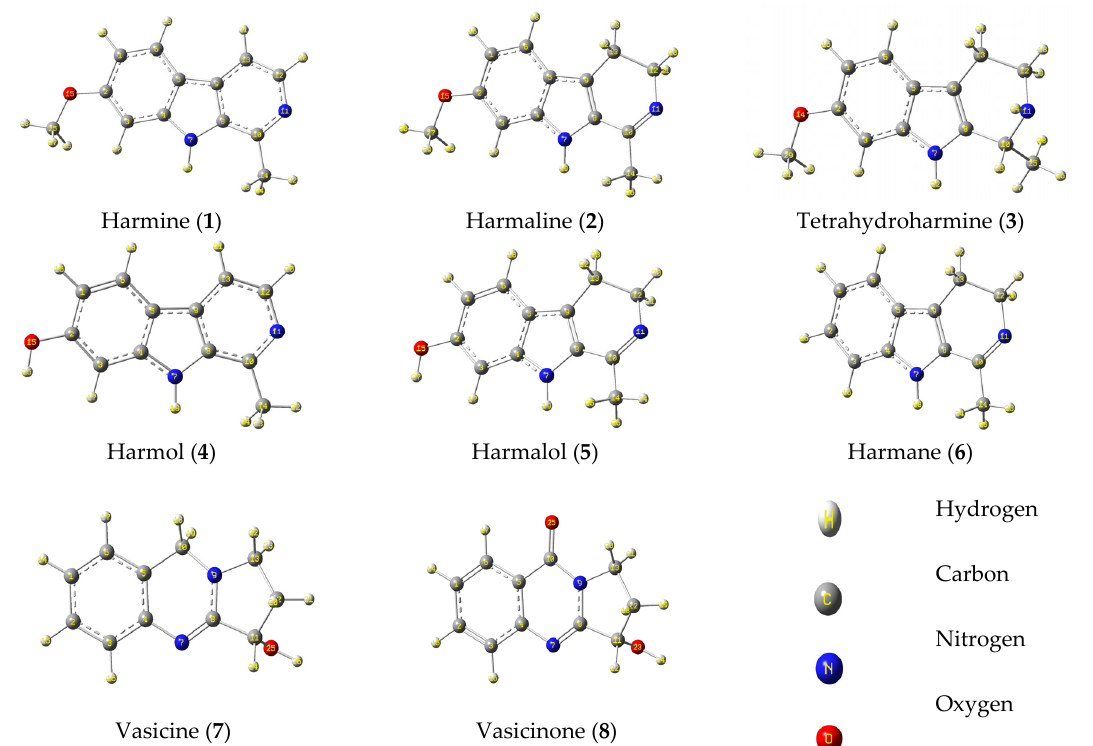
Figure 14. Optimized structures of the stable conformers for the neutral form of organic molecules 1 – 8 present in the extract of Harmal leaves computed at the B3LYP/6-311G++(d,p) in water using the PCM solvation model [49].